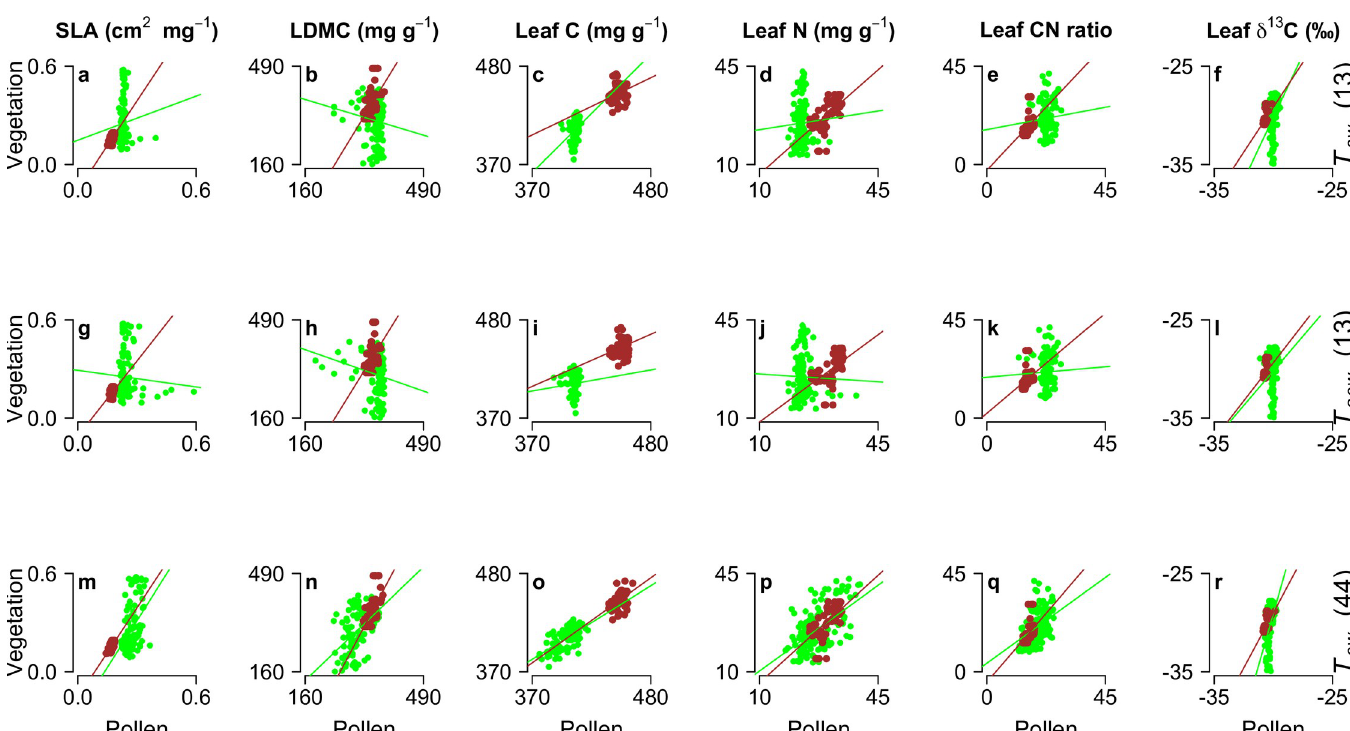
Fig 3. Linear relationships between the CWMs of herbaceous (green circles) and woody (brown circles) vegetation and modern pollen before (top row, panels a to f) and after (middle row, panels g to l) relative pollen productivity (RPP) adjustment ( T cw and T acw , respectively) using the 13 pollen types (eight herbaceous and five woody types) for which RPP estimates were available. The bottom row (panels m to r) shows the relationship between vegetation and modern pollen including all 44 pollen types (34 herbaceous and 10 woody types) with and without RPP estimates and with trait data available. Marginal r 2 and RMSEP values of linear mixed effects models (LMEs) of the standing vegetation as a function of the modern pollen data are shown in Table 1. Marginal r 2 and RMSEP were used to determine how well plot- level mean trait data of the modern pollen assemblages can predict mean trait values of the modern fen vegetation.